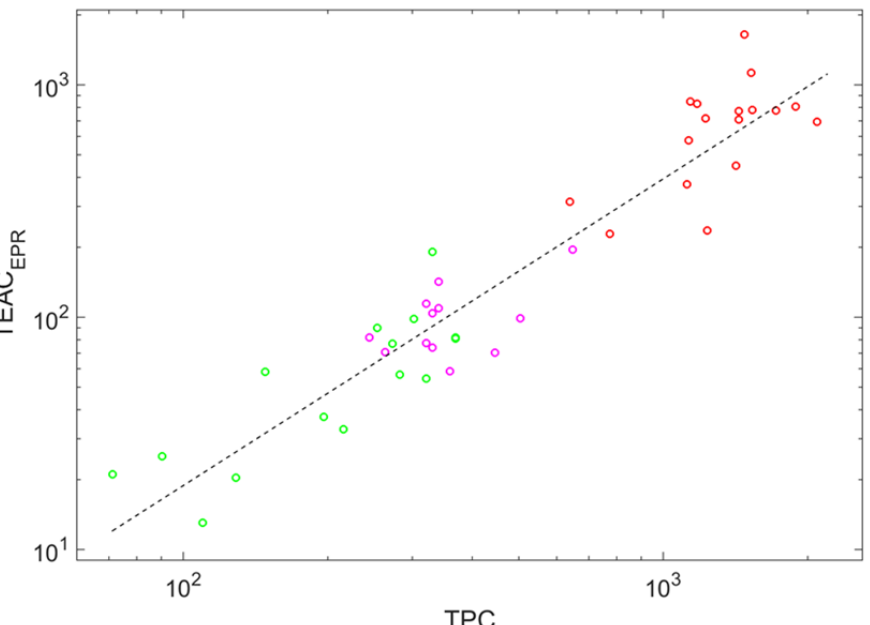
Figure 3. Double logarithmic plot showing the power-law dependence of the trolox equivalent antioxidant capacity determined by the EPR method on the total phenolic content; the dashed line shows the fit of these data stated by Equation (2). Circle color indicates wine color: red (red wines), magenta (rose wines), and green (white